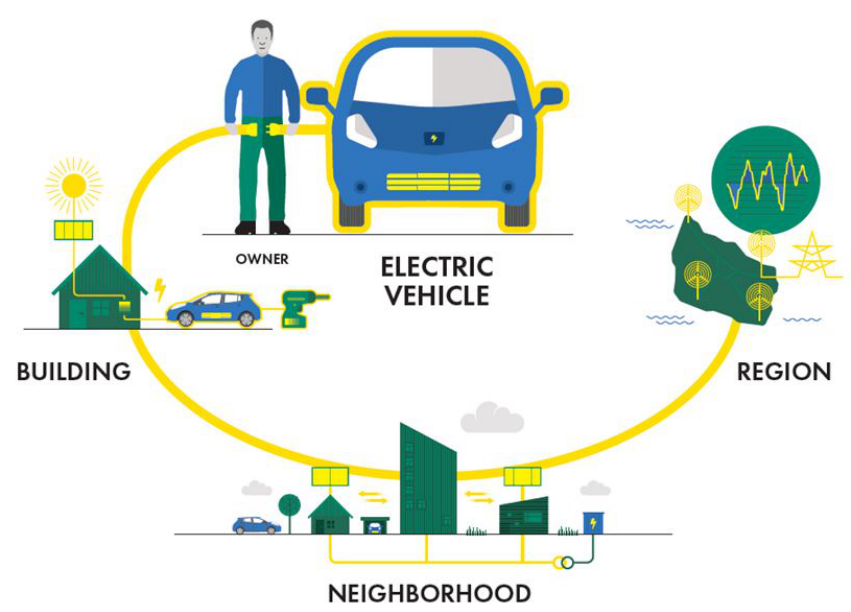
Figure 1. Vehicle–Grid Integration—possible uses of the EV.